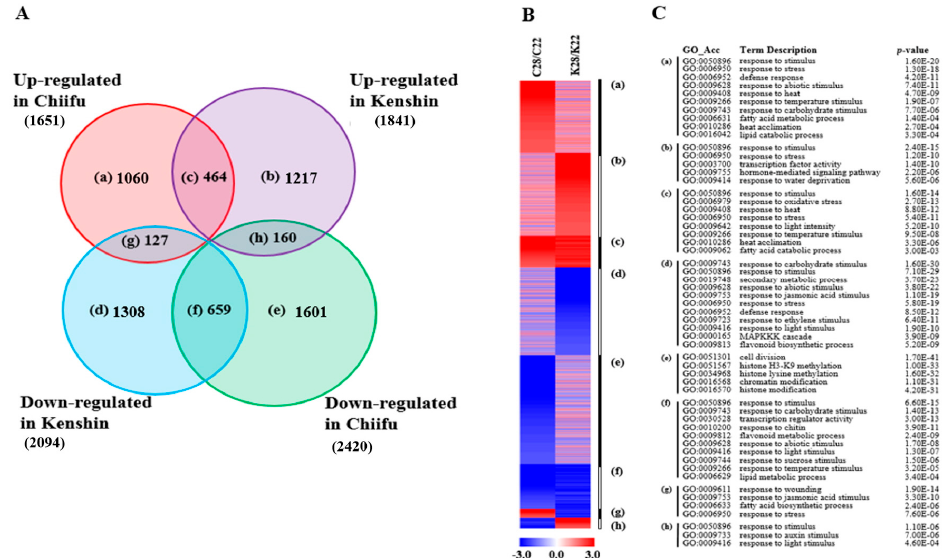
Figure 3. Analysis of minor warming-responsive genes from two contrasting inbred lines, Chiifu and Kenshin. ( A ) Venn diagram of DEGs with over 2-fold differences in expression; a–h indicate the groups of genes in each category; ( B ) Heatmap of DEGs in each group based on fold change; ( C ) GO enrichment analysis of DEGs in each group, with p values obtained using the agriGO tool (http://bioinfo.cau.edu.cn/agriGO/index.php). C and K of Figure 3B indicate Chiifu and Kenshin, respectively.